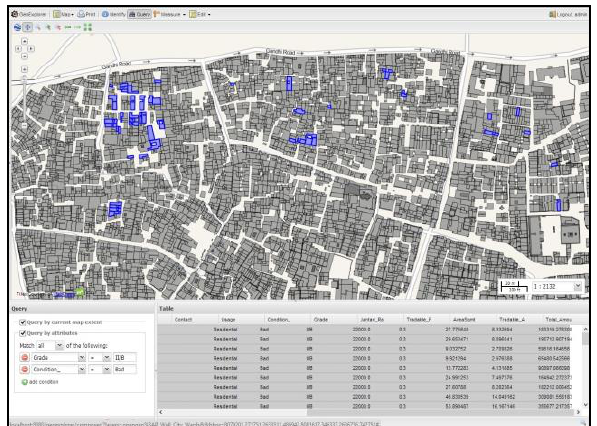
Figure 7. Search result using multiple parameters